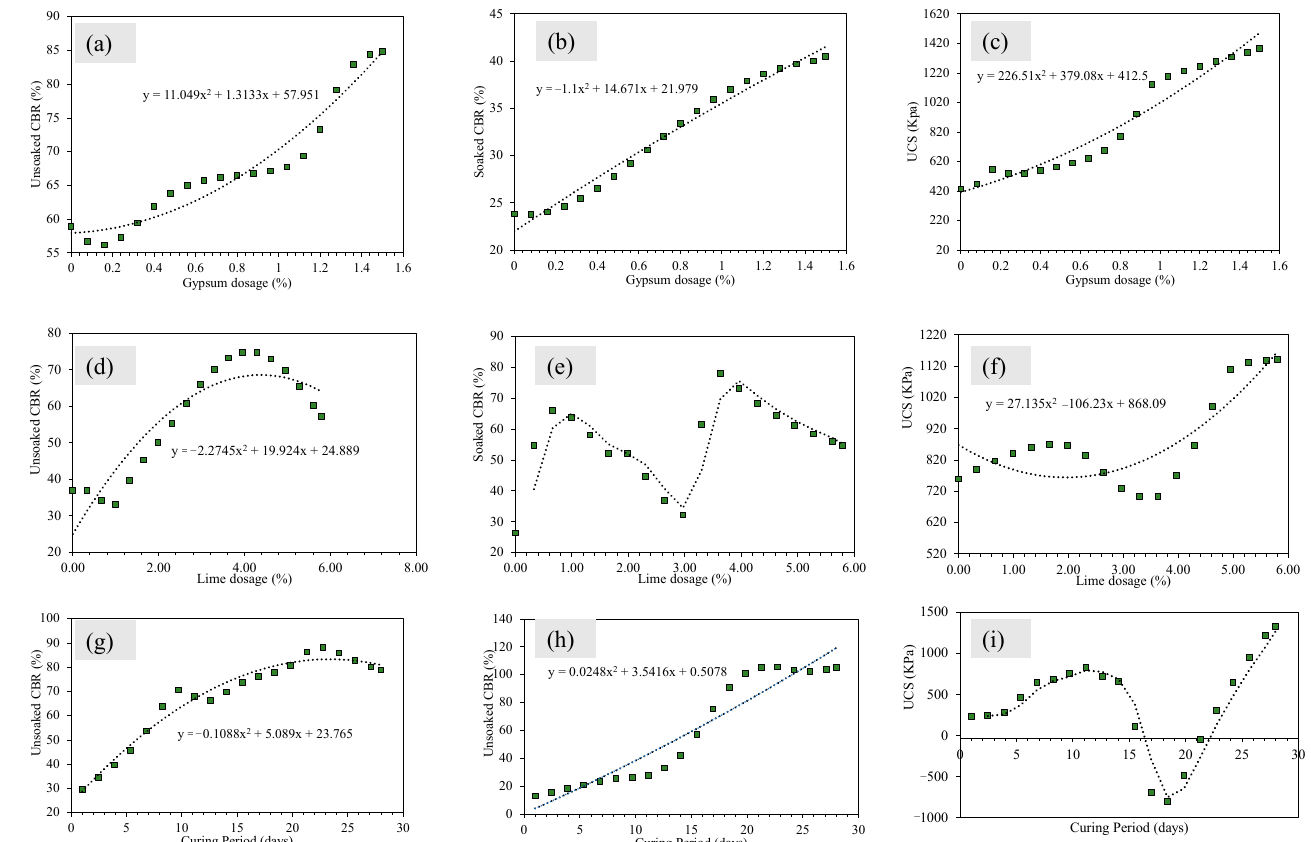
−− Figure 9. Parametric or monotonicity analysis of the developed ANN models for the simulated data of unsoaked CBR ( a , d , g ), soaked CBR ( b , e , h ), and UCS data ( c , f , i ).